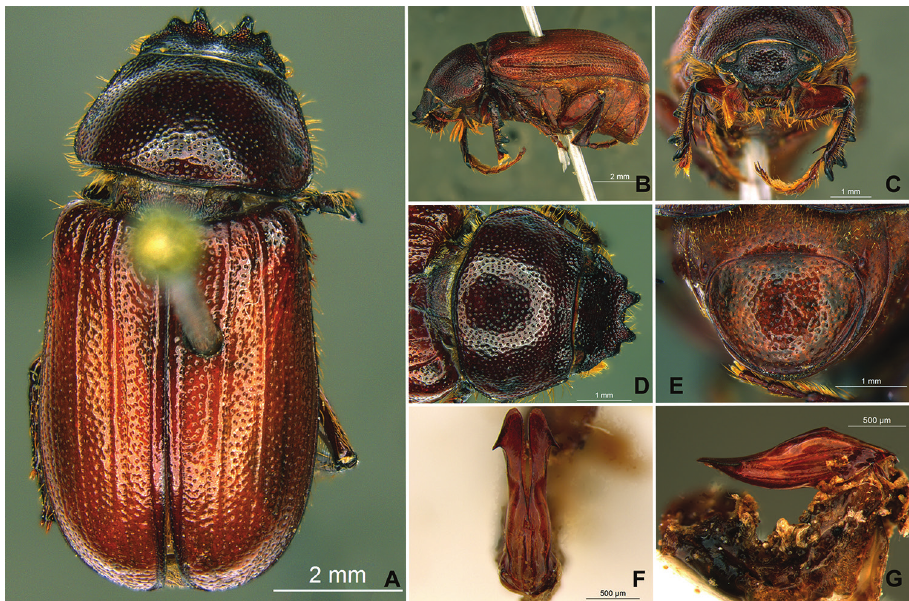
Figure 82. Liogenys rotundicollis Cherman, sp. n. A Dorsal view B Lateral view C Frontal view D Clypeus and pronotum E Pygidium F Parameres, dorsal view G Parameres, lateral